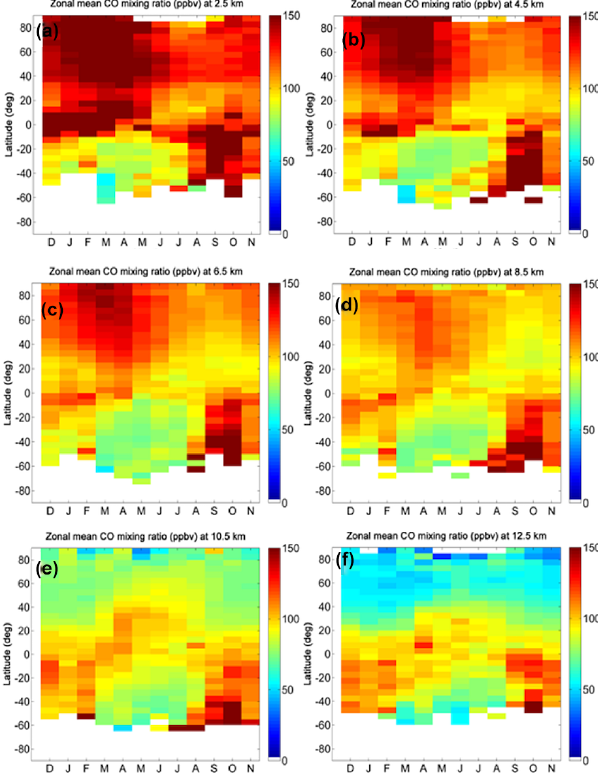
Figure 16. Seasonal variation of zonal monthly mean trajectory- mapped MOZAIC-IAGOS CO climatology at 2.5, 4.5, 6.5, 8.5, 10.5, and 12.5km altitudes for the period 2001–2012. The zonal mean data are averaged in 5 ◦ latitude intervals.